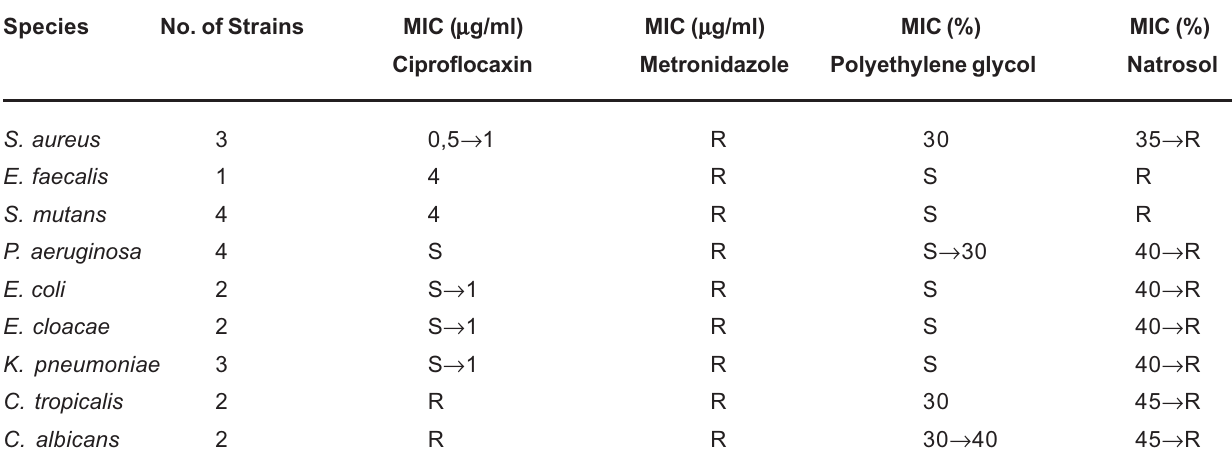
R = resistant at the highest concentration tested (16 µ g/ml or 50%); S = sensitive at the lowest concentration tested (0.25 µ g/ ml or 25%); → interval of concentration of the tested products